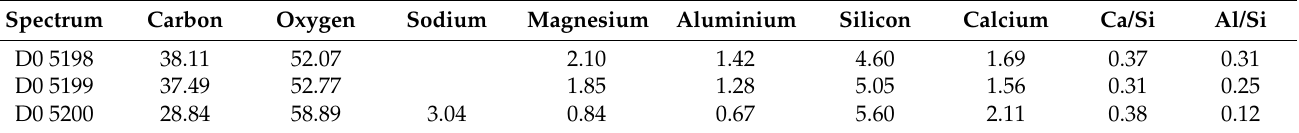
Table 4. Results of EDS analysis.